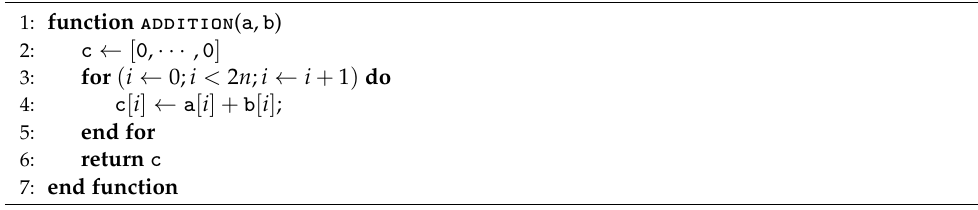
Algorithm 12 Computes the addition of two ring elements